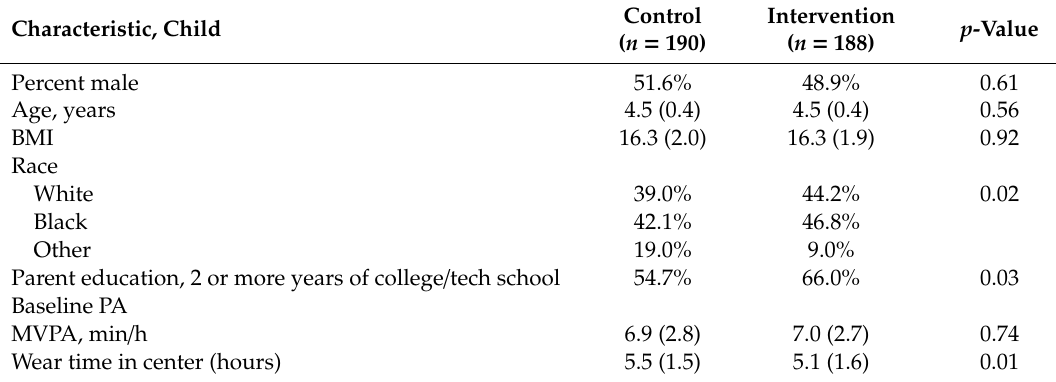
Table 1. Baseline characteristics of 378 children: mean (SD) or percent. BMI: Body Mass Index; MVPA: moderate-to-vigorous physical activity.